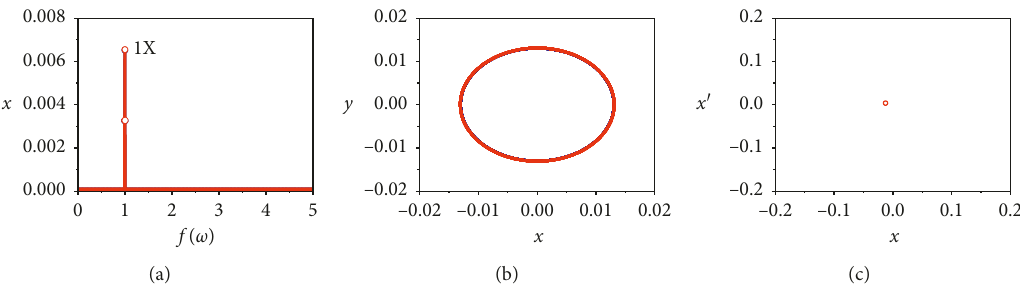
Figure 9: The response of the rotor/seal system with the DVA at s rotor. (c) The Poincar´e map of the x coordinate.